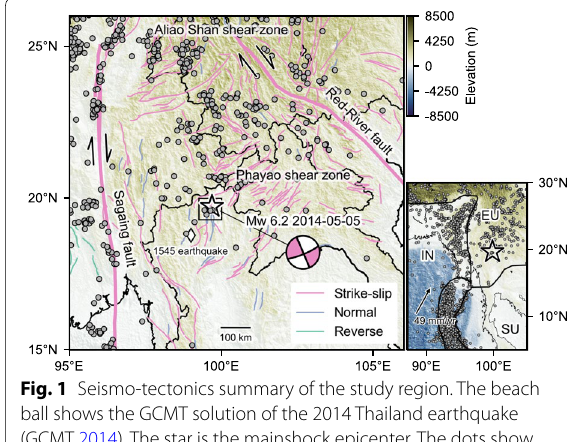
Fig. 1 Seismo-tectonics summary of the study region. The beach ball shows the GCMT solution of the 2014 Thailand earthquake (GCMT 2014). The star is the mainshock epicenter. The dots show the seismicity (M 5 or larger) between 1970 and 2014 from the ISC Bulletin (ISC 2021). The rectangle denotes the map region of Fig. 2. The lines are the active faults (Styron and Pagani 2020). The right panel shows the tectonic setting. The black line shows the plate boundaries (Bird et al. 2003). IN: India Plate, EU; Eurasia Plate, SU; Sunda Plate. The arrow shows the relative plate motion with the convergence of the India Plate toward the fixed Eurasia Plate (DeMets et al. 2010). The bathymetry/topography is from SRTM15 et al. 2019)